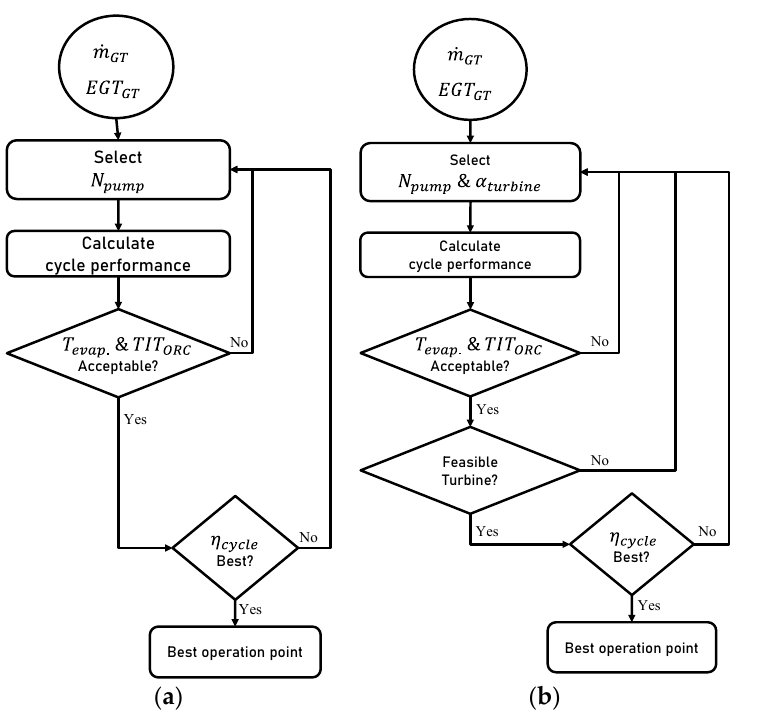
Figure 5. Selecting optimum cycle: ( a ) Sliding pressure; ( b ) VAN/PA turbine.